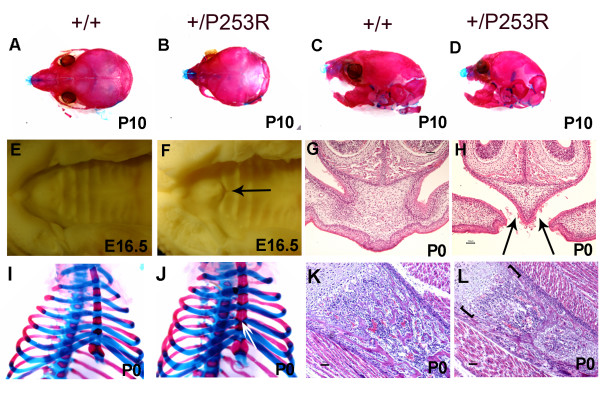
Abnormal gross appearance and histology of Fgfr2+/P253R mice. A-D) Alizarin red S and Alcian blue staining of the skull shows domed-shaped skulls with shortened anterioposterior length, short nasal snouts and upper jaw in mutant; I, J) Alizarin red S and Alcian blue staining of the chest shows abnormal bony fusion of sternum (white arrow) in mutant. E-H) Palate abnormalities: (E, F) Superior view shows a defect located at the junction between the primary and secondary palate in mutant (arrow). (G, H) Histology shows incomplete fusion in mutant (arrows). (K, L) Abnormal chondro-osseous transition at the physis in mutant (brackets). Panels A, C, E, G, I, and K are from littermate controls. Panels B, D, F, H, J, and L are the corresponding organs and tissues in mutant mice. (Scale bars: I-P = 50 μm).